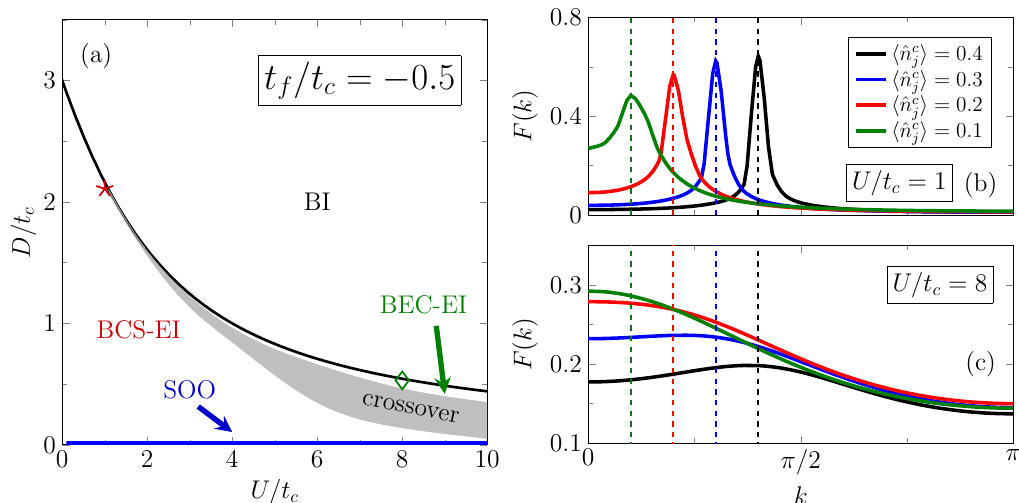
Figure 1: (a) DMRG ground-state phase diagram of the 1D half-filled EFKM, showing an excitonic insulator (EI) state (of BCS- respectively BEC-type) sandwiched between band insulator (BI) and staggered orbital order (SOO) phases. Star ( (cid:63) ) and diamond ( (cid:5) ) symbols mark the parameter sets that will be used in simulations of the spectral functions A ( k , ω ) in Sec. 3. (b) and (c): Condensation amplitudes F ( k ) at various 〈 ˆ n c 〉 for U / t = 1 and 8. Data obtained by DMRG with periodic boundary conditions c j for L = 60 (we checked that for such a large system finite-size effects are negligible). = π 〈 ˆ n c 〉 in the noninteracting Dashed lines give the corresponding Fermi momenta k F j / t = − limit. In all cases, t f c